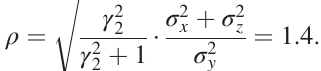
FIG. 2. Profile function f . ffiffiffiffiffiffiffiffiffiffiffiffiffiffiffiffiffiffiffiffiffiffiffiffiffiffiffiffiffiffiffi